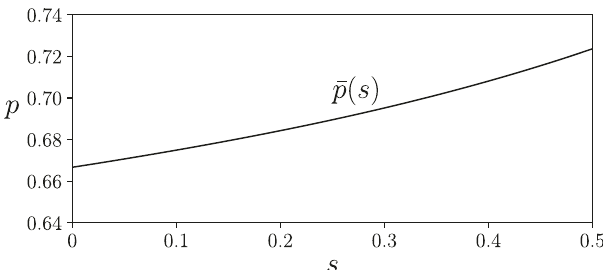
Fig. 5 Nonadditivity in a low-noise channel. For the low-noise qutrit with noise parameter 0 < s ≤ 1/2, 0 : 695 (cid:7) Q ð 1 Þ ð B channel B 1